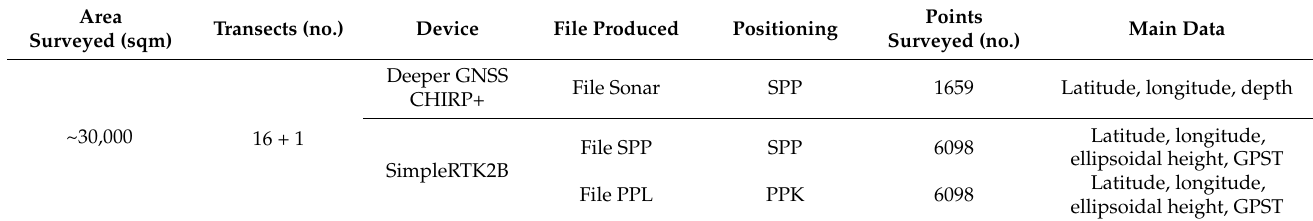
Table 7. Datasets for 3D modelling of the seabed (natural surface).